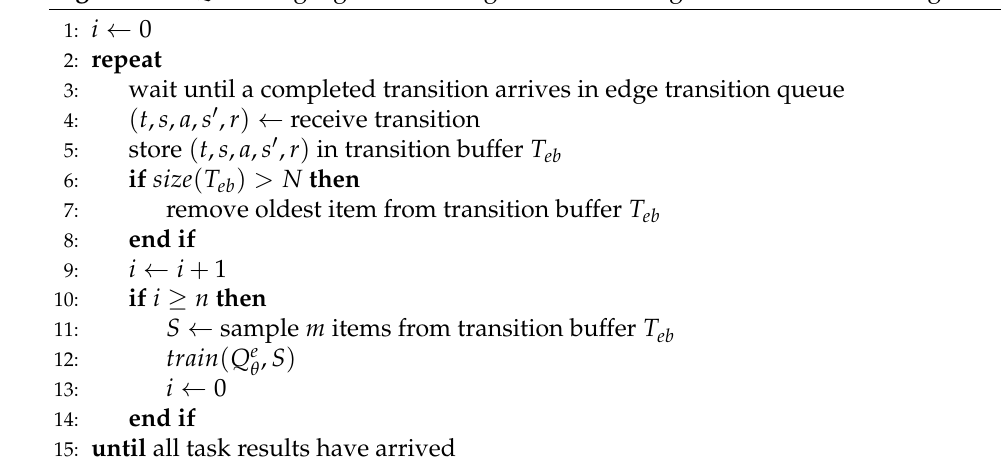
Algorithm 8 Q-training algorithm in edge devices for edge level decision